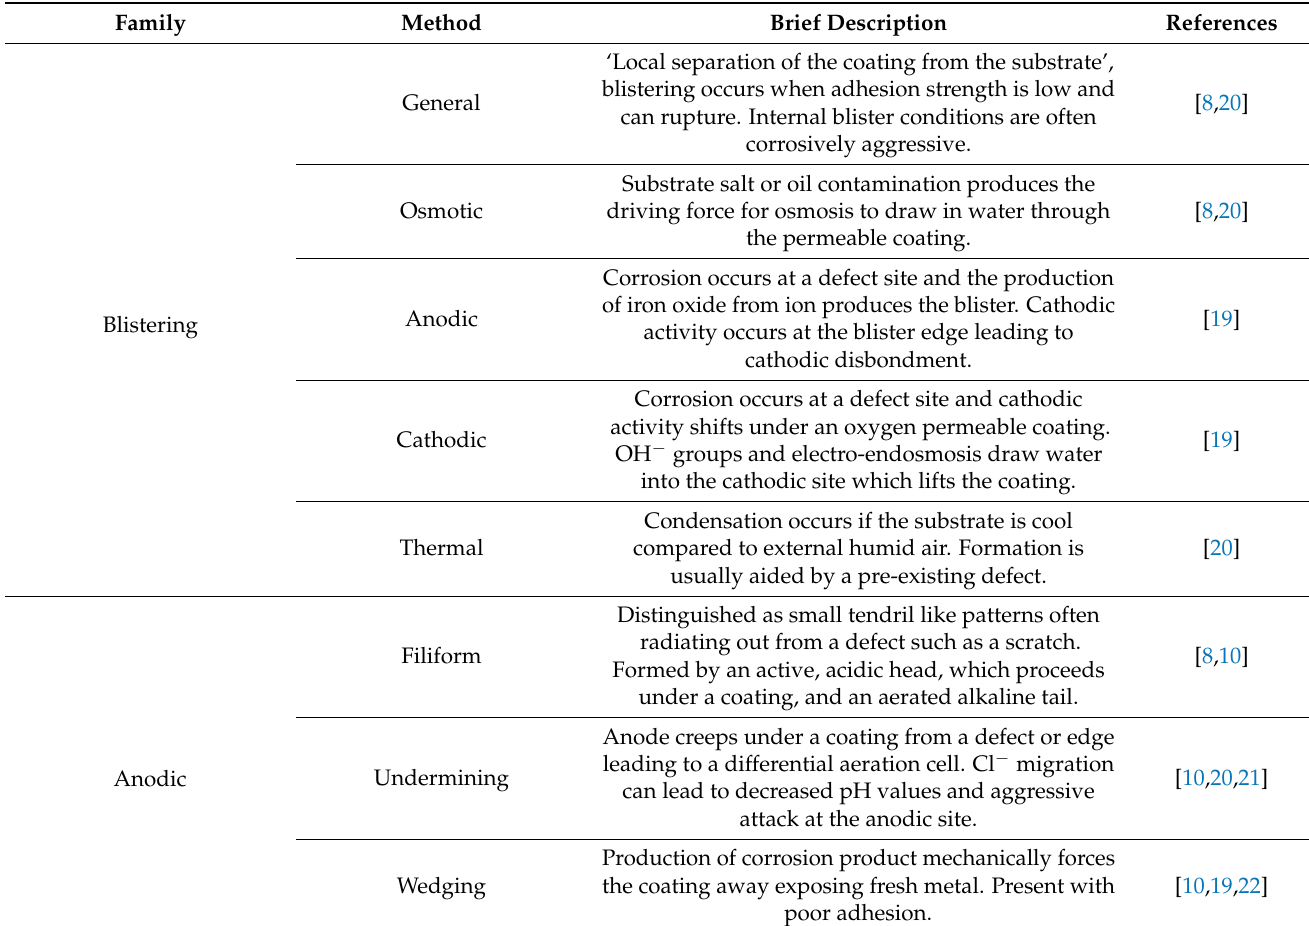
Table 4. Under film corrosion